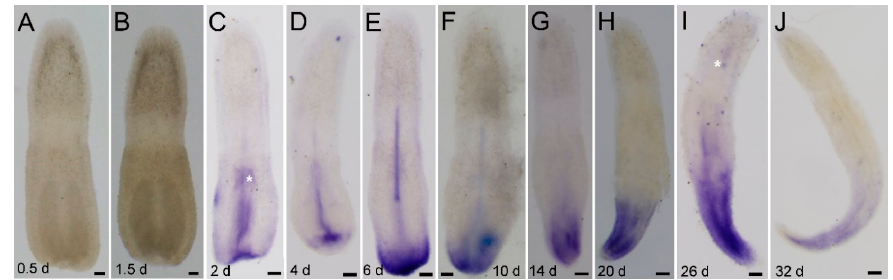
Figure 6. Ls-pcna expression during the posterior regeneration of Lineus sanguineus . ( A , B ) Images from 0.5 and 1.5 dpa, respectively. ( C ) Image from 2 dpa, expressing in the wound and proboscis. ( D ) Image from 4 dpa, expressing in proboscis and near the posterior end. ( E , F ) Images from 6 and 10 dpa, respectively, expressing in the posterior end and proboscis. ( G – J ) Images from 14, 20, 26, and 32 dpa, respectively, expressing at the posterior end. Asterisks mark nonspecific staining (see Figure S4, Supplementary Materials). Scale bars = 100 µ